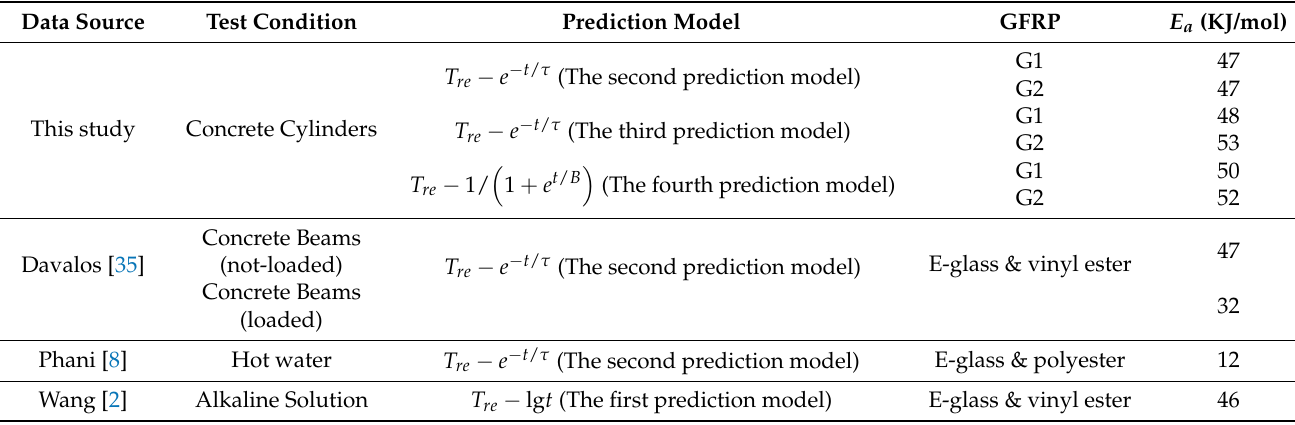
Table 20. Activation energy as determined in different